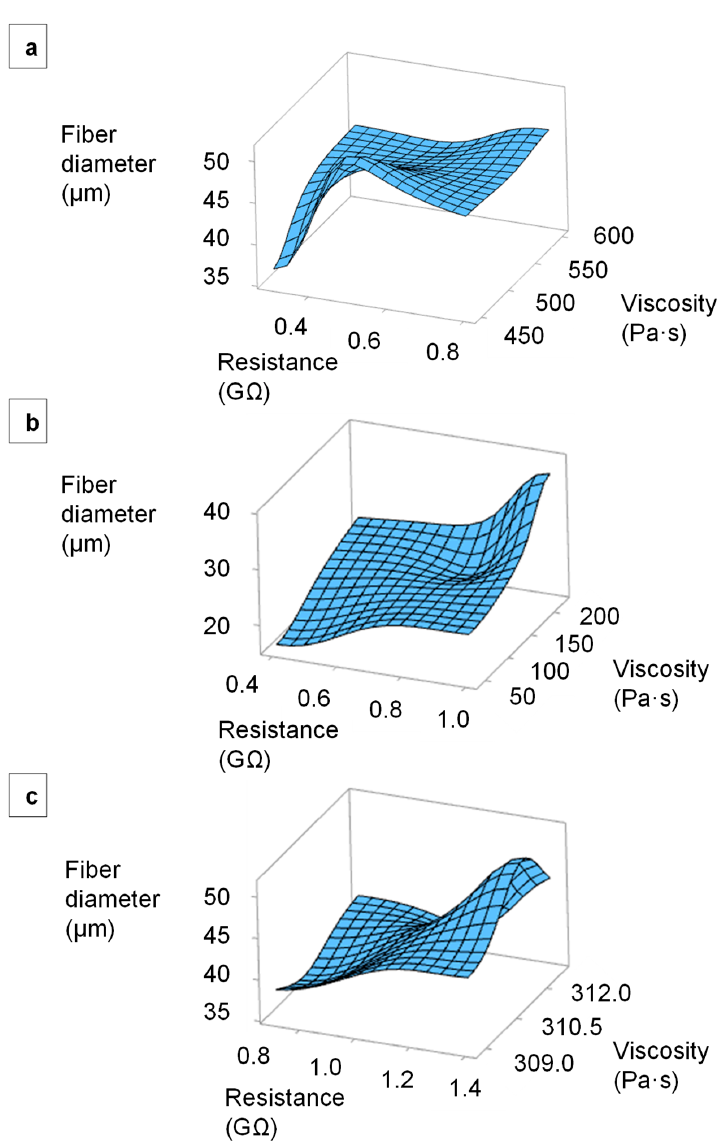
Figure 15. Surface plots of fiber diameters in relation to the electrical resistance and viscosity of the melt. ( a ) PLA / alizarin compounds. ( b ) PLA / hematoxylin compounds. ( c ) PLA / quercetin melt. ( a ) PLA/alizarin compounds. ( b ) PLA/hematoxylin compounds. ( c ) PLA/quercetin compounds.